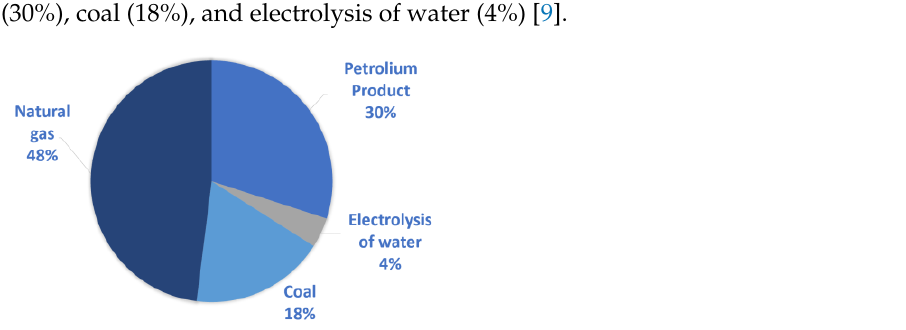
Figure 1. Percentage of production of hydrogen from petroleum products, natural gases, coal, and electrolysis of water. Values taken from [9].